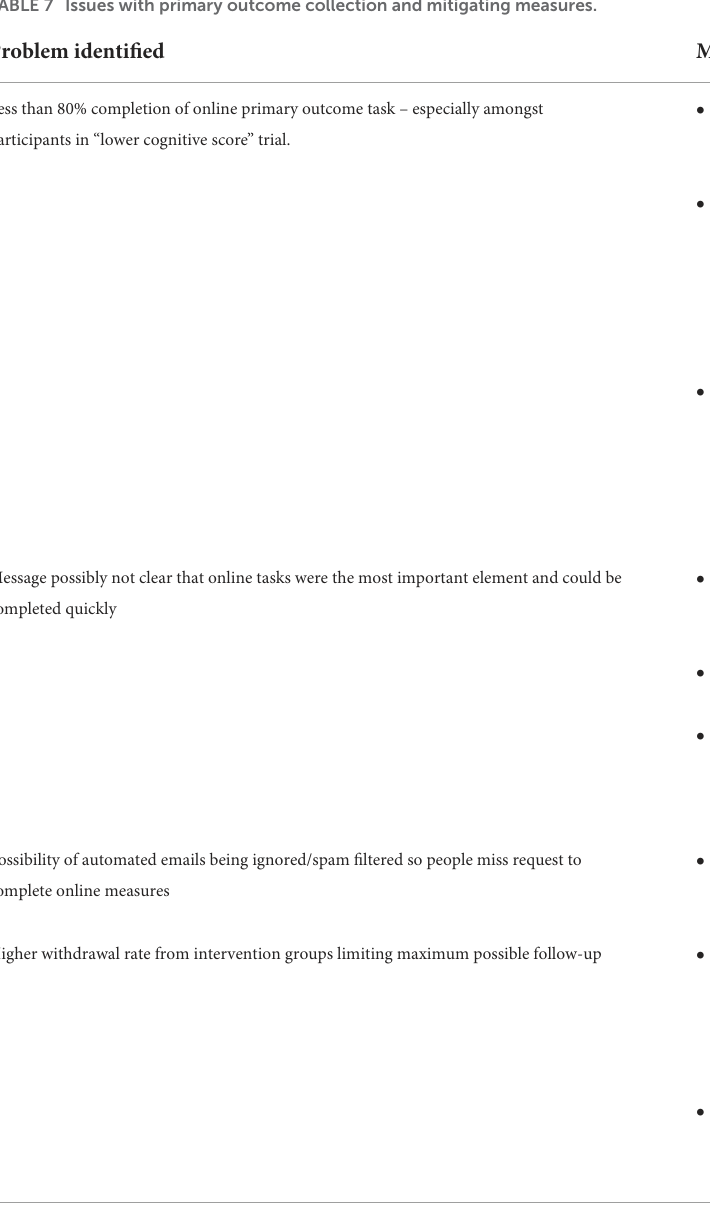
TABLE 7 Issues with primary outcome collection and mitigating